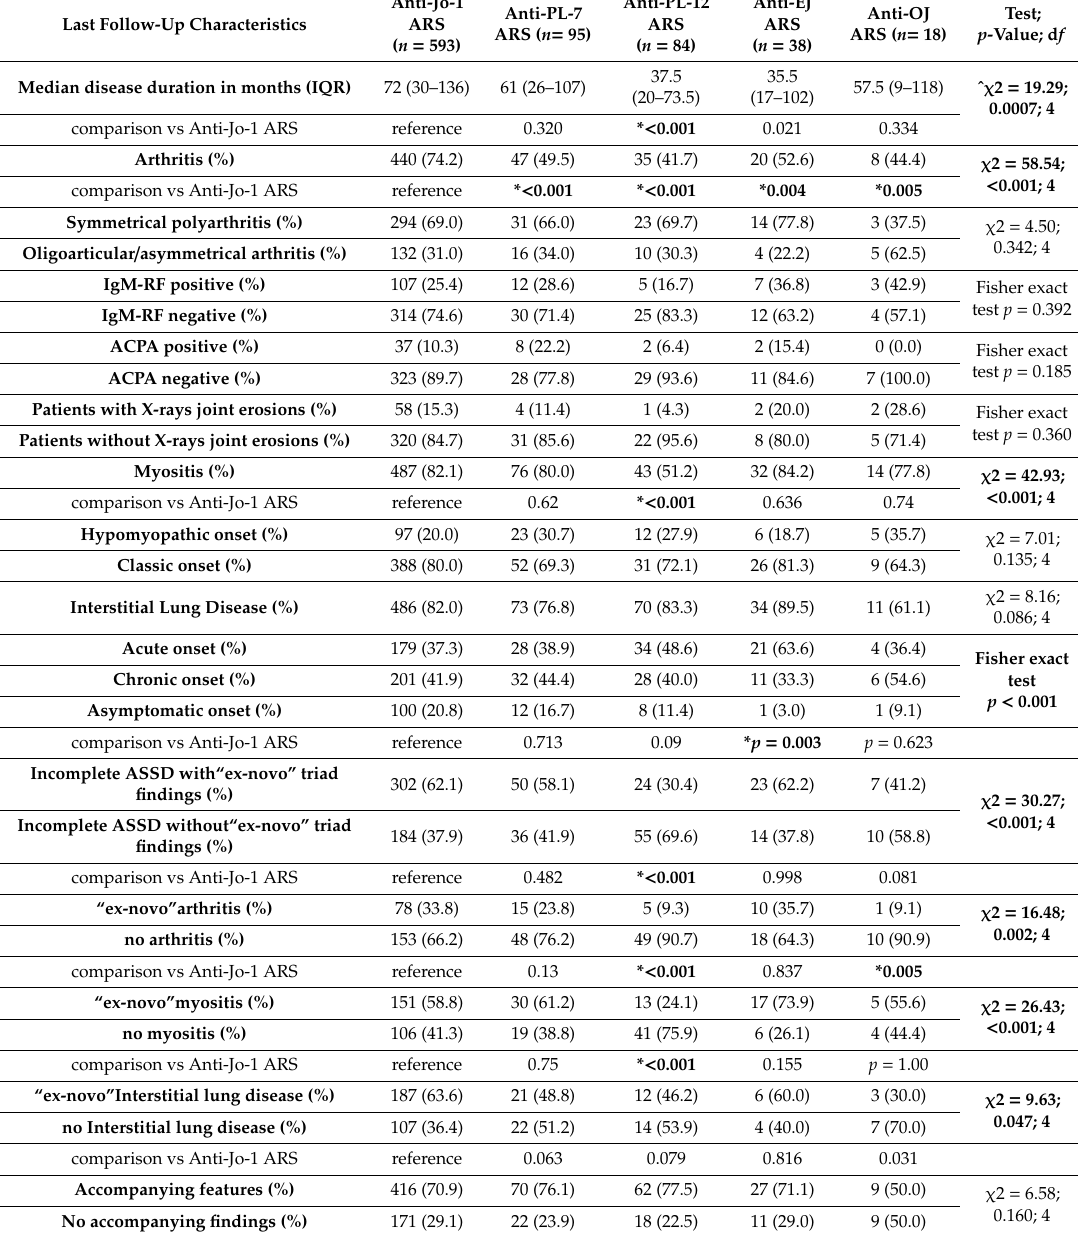
Table 2. Characteristics of included patients at last